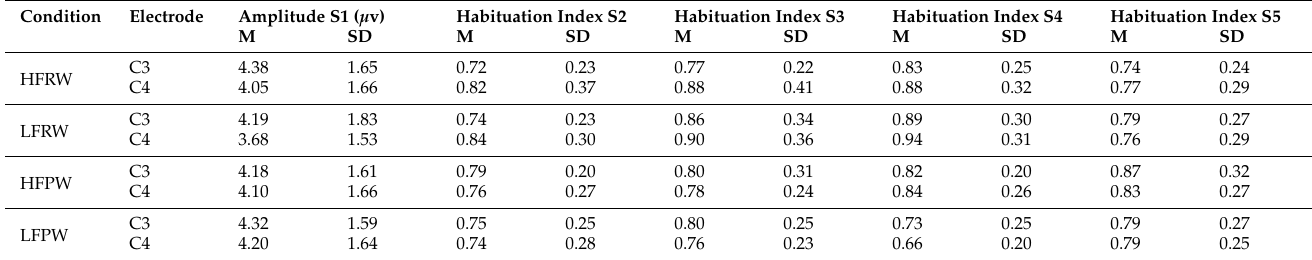
Table 1. Peak-to-peak amplitudes of the N1 responses (i.e., measured as N1-P1) at S1, and the N1 habituation index for the four repeated positions in the two electrodes of interest (C3 and C4).